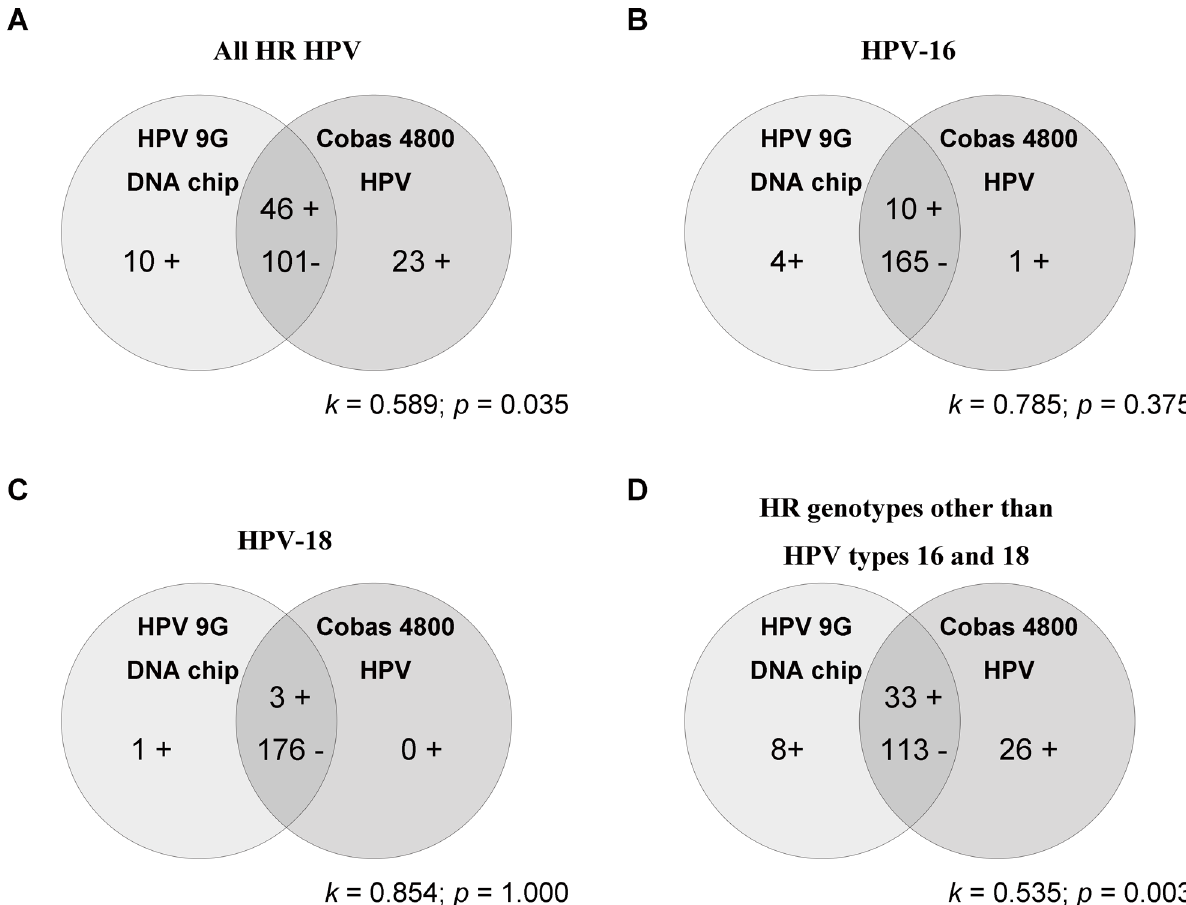
Fig 1. Concordance between the results of two HPV DNA tests according to high-risk (HR) HPV genotypes. (Abbreviations: k , kappa coefficient).